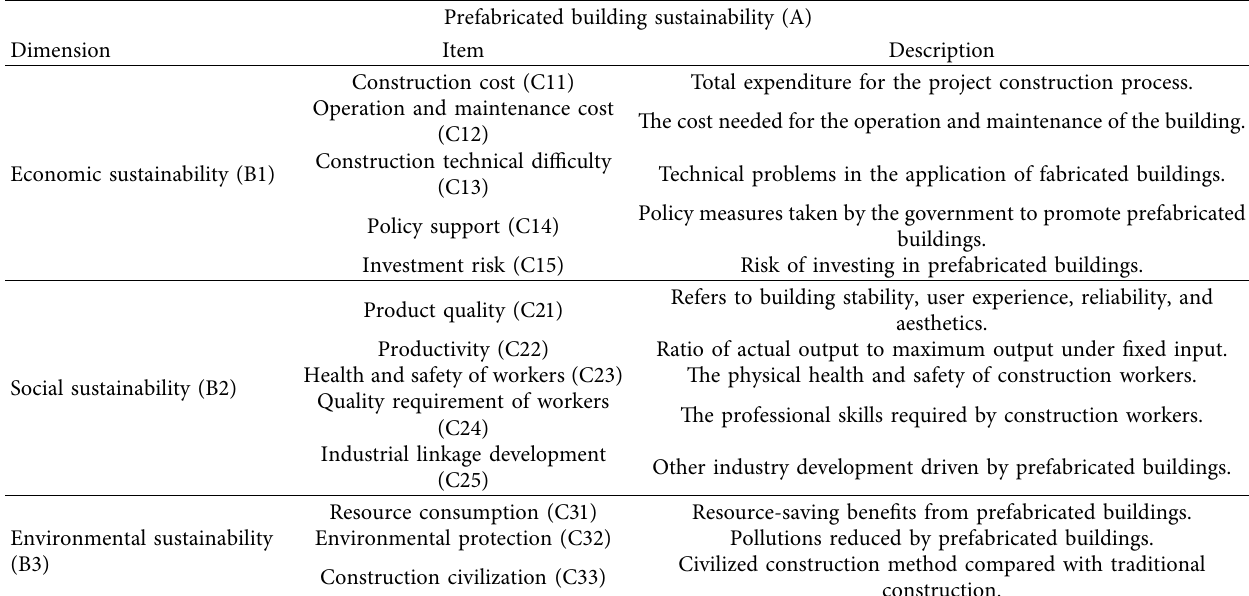
Table 1: Critical sustainability items for prefabricated buildings.